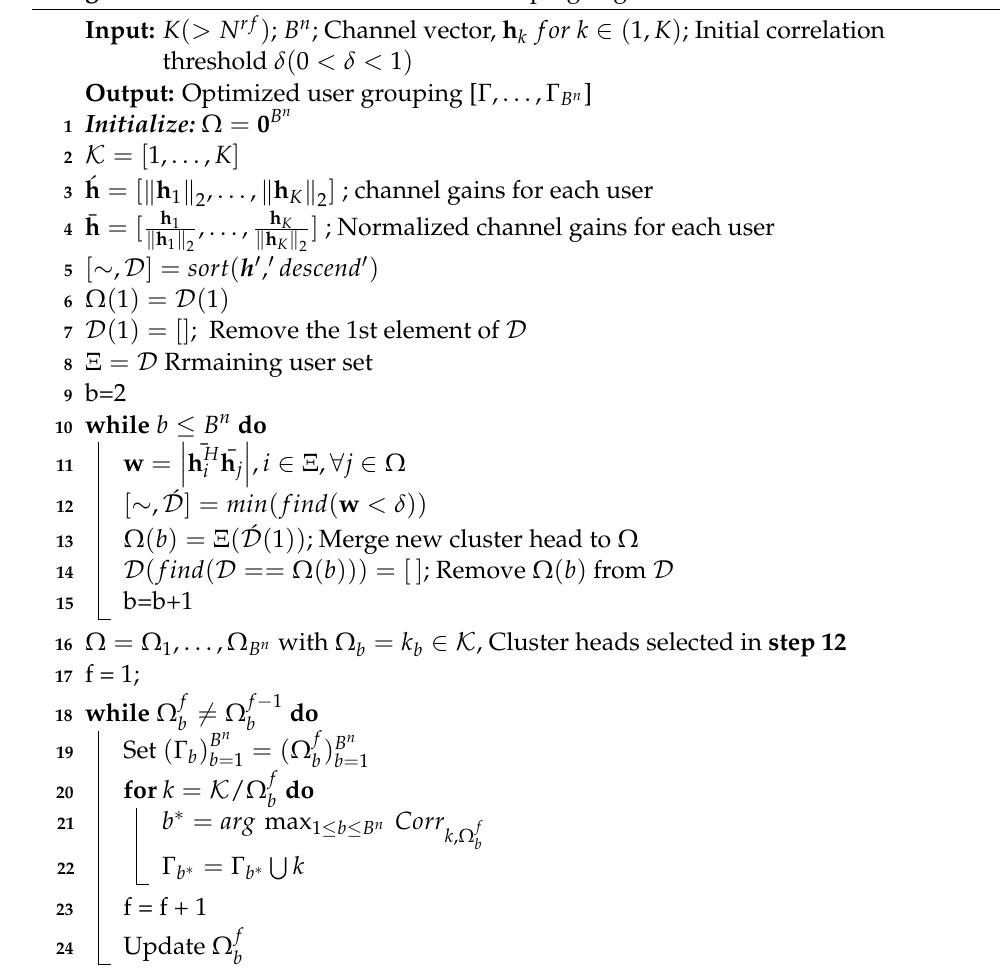
Algorithm 1 Modified K-Means User Grouping